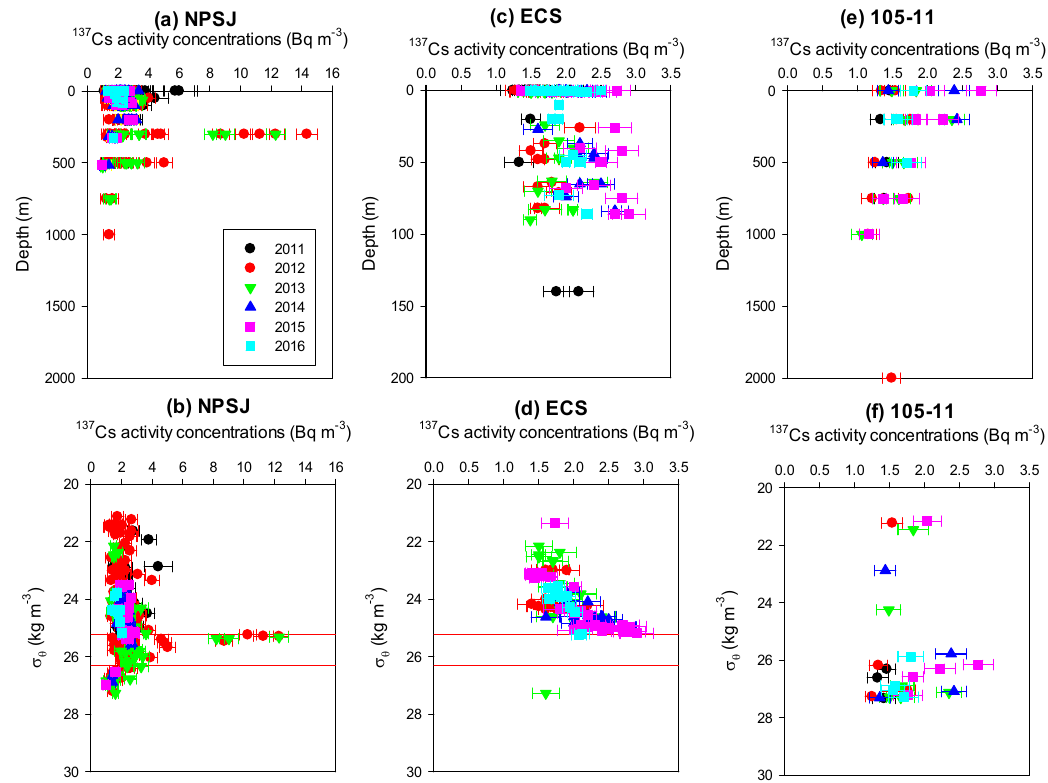
Figure 6. Vertical distributions of the 137 Cs activity concentrations over the (a) depth profile in the NPSJ, (b) potential water density anomaly profile in the NPSJ, (c) depth profile in the ECS, (d) potential water density profile in the ECS, (e) depth profile at 105-01 along the WTWC and (f) potential water density anomaly profile at 105-01 along the western TWC. Colour indicates the collection time